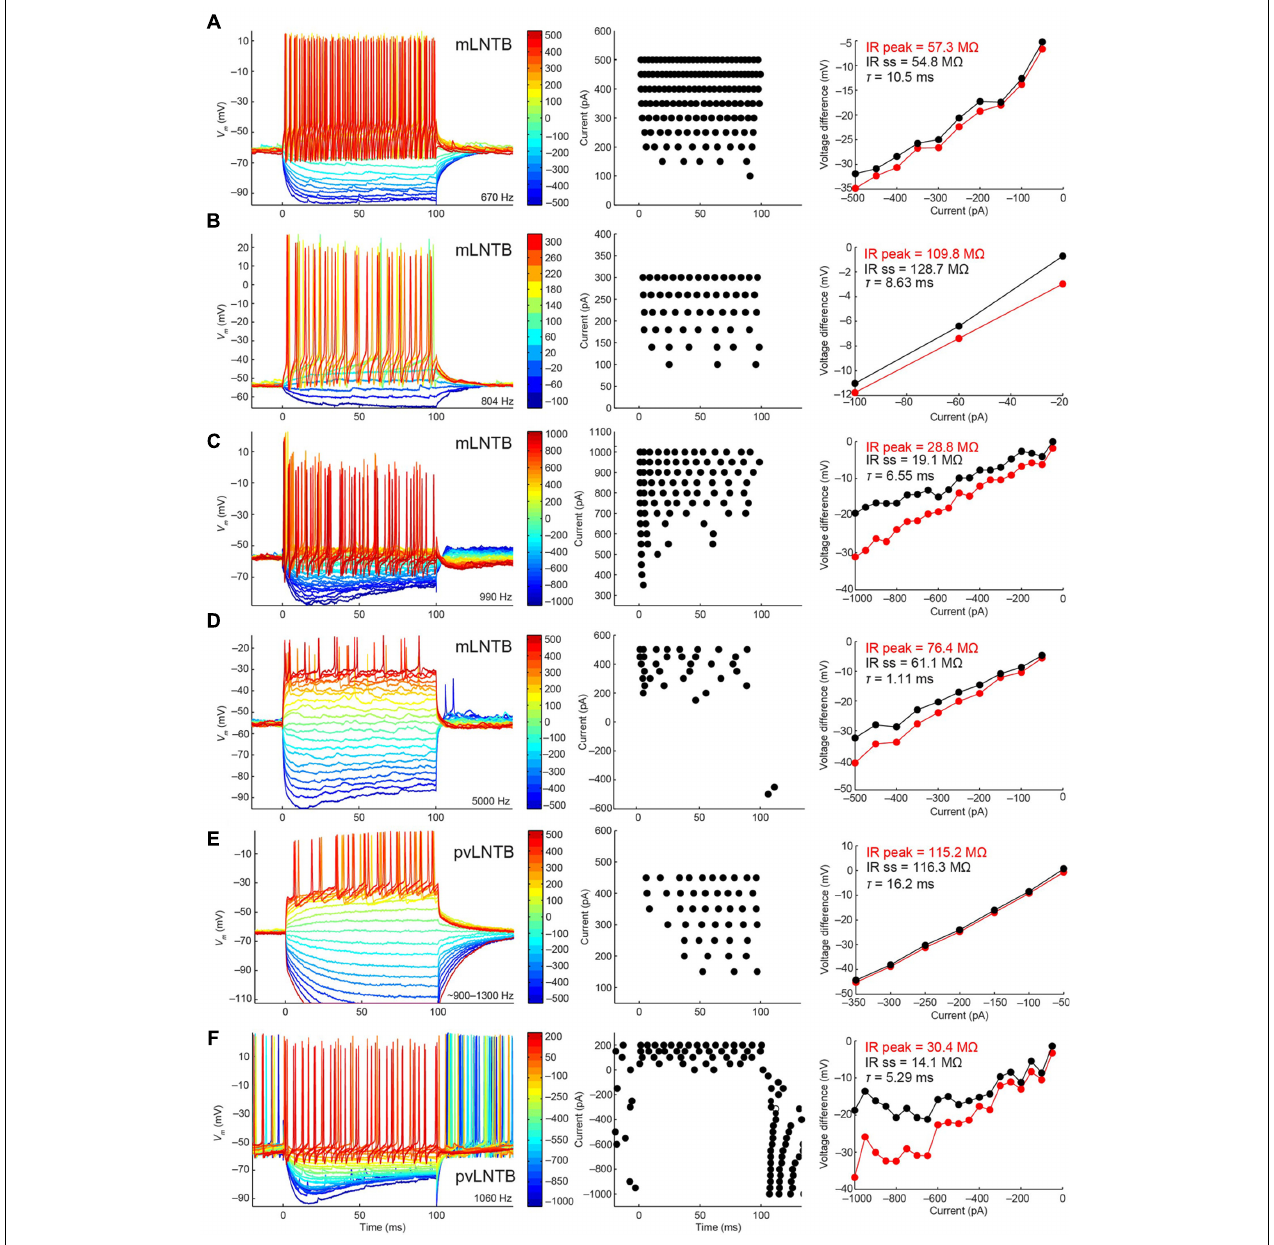
FIGURE 7 | Voltage response to current steps for LNTB neurons. Voltage response to current injections is shown for six neurons: four mLNTB neurons (A–D) and two pvLNTB neurons (E,F) . Left panels show voltage responses to hyperpolarizing and depolarizing current steps (color legend shows current amplitude in pA). Middle panels are dot rasters showing the action potentials from the left panels. Right panels are IV plots of the hyperpolarizing responses from the left panels, plotted separately for the peak and steady state response. The peak and steady state input resistance (IR) as well as the membrane time constant ( τ ) are mentioned in each panel. The bridge was sometimes not well-balanced, especially for the cell shown in (E) . A post hoc calculation of the resistance showed that the true series resistance for this cell is about 108.6 M (cid:127) (the bridge was balanced for 75.7 M (cid:127) ). The input resistance mentioned in (E) was corrected for this